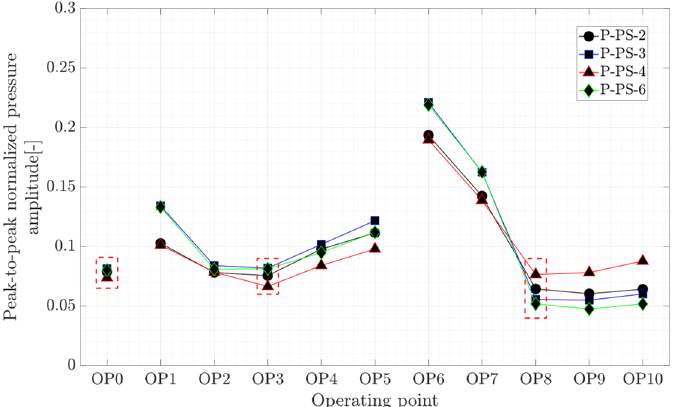
Figure 10. Peak-to-peak normalized pressure amplitude of four pressure transducers on the runner blade at OP0–OP10; red dashed-line boxes indicate the on-cam operating points.